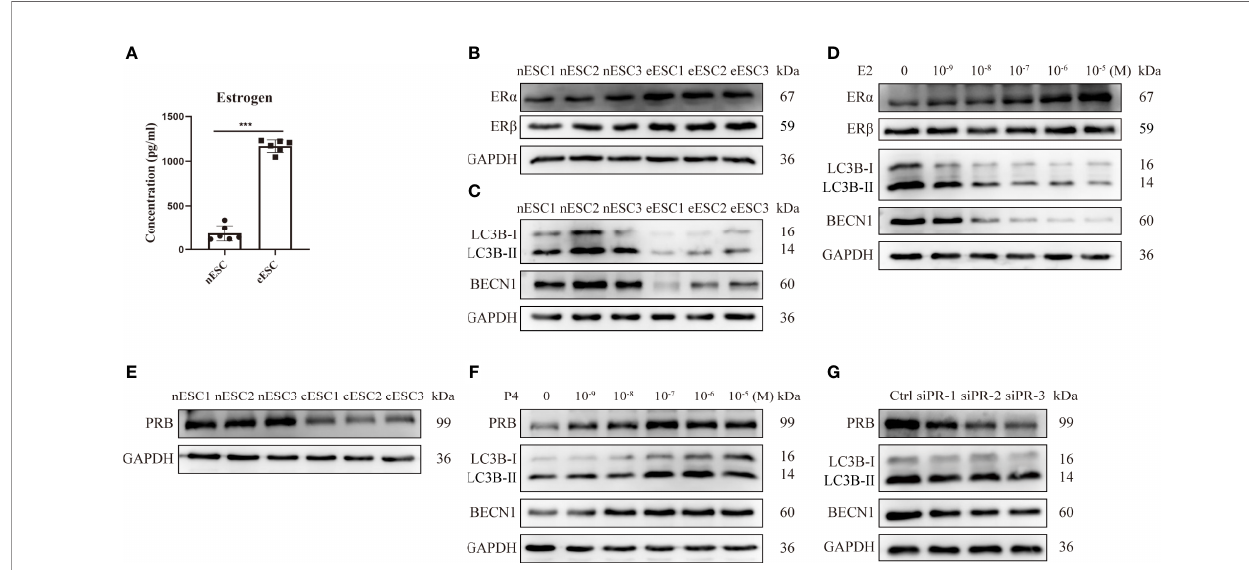
FIGURE 3 | The ER a /PR imbalance contributes to the hypo-autophagy state of eESCs. (A) ELISA was used to detect the estrogen concentrations of eESCs and nESCs (n = 6), both of which were cultured in culture fl asks for 24 h. (B, C) The protein expressions of ER a , ER b , LC3B-II/I, and BECN1 of eESCs and nESCs were analyzed via Western blotting. (D) After treatment with different concentrations of E2 for 48 h, the expression levels of ER a , ER b , LC3B-II/I, and BECN1 in eESCs were analyzed via Western blotting. (E) The protein expressions of PRB in eESCs and nESCs were detected via Western blotting. (F) After treatment with different concentrations of progesterone for 48 h, the protein levels of PRB, LC3B-II/I, and BECN1 in eESCs were analyzed via Western blotting. (G) The protein levels of PRB, LC3B-II/I, and BECN1 in eESCs after PR silencing were analyzed via Western blotting. Continuous data are presented as the mean ± SD (*** P < 0.001).